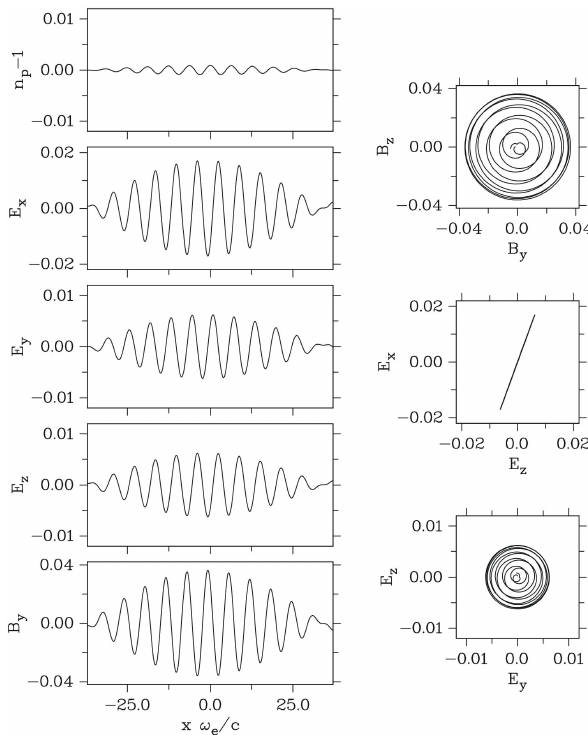
Fig. 8. Spatial profiles of whistler oscillitons for θ = 70 ◦ and U = 0 . 172 V Ae . From top to bottom: proton density (n p − n po )/n po , three components of the electric field (in units of E o = V Ae B o ) and the magnetic field component B y /B o . The right panels show the hodographs B z versus B y , E x versus E z , and E z versus E y .